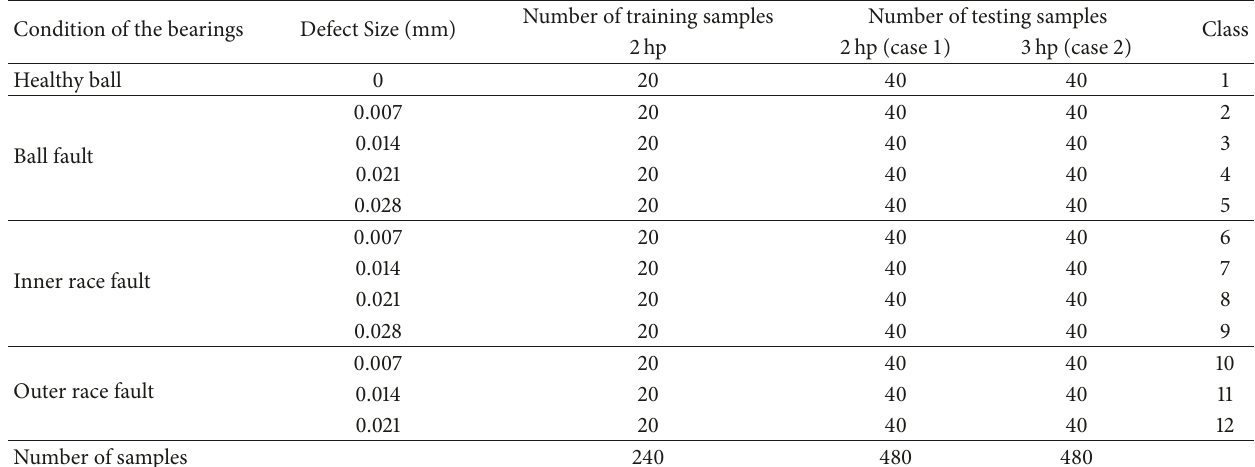
Table 1: The detailed information of the used vibration